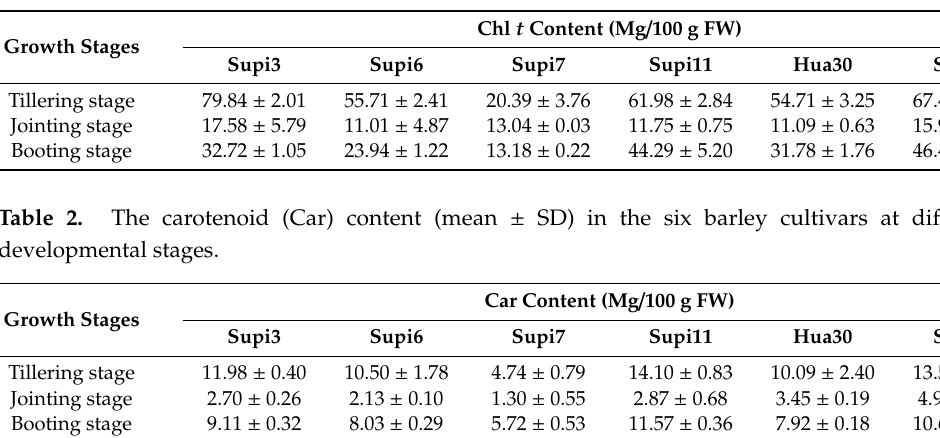
Table 1. Total chlorophyll (Chl t ) content (mean ± standard deviation, SD) in the six barley cultivars at di ff erent developmental stages.